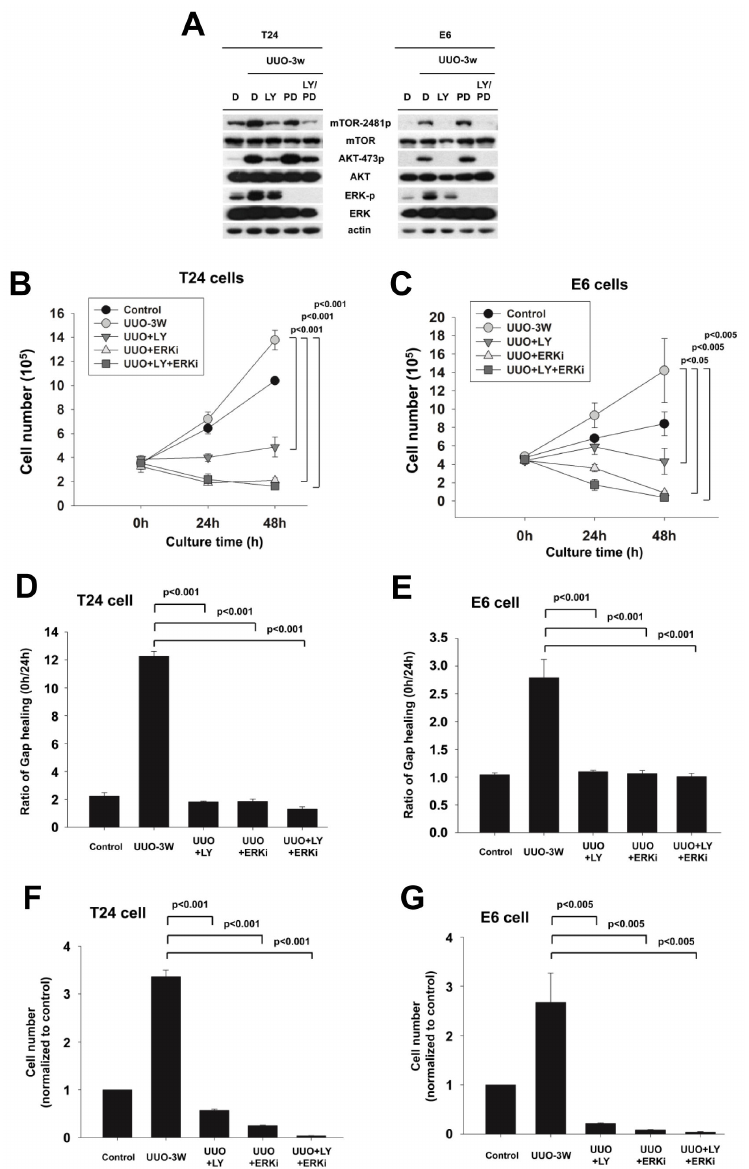
Figure 6. Inhibition of mTORC2-AKT and ERK signaling pathway reduced T24 cells and E6 cells cell viability, migration and invasion in hydronephrotic urine treatment. To confirm the importance of mTORC2-AKT and ERK signaling pathway in T24 and E6 cells after the treatment of hydronephrotic urine, we used LY294002 (PI3K inhibitor) and PD184352 (ERK inhibitor) to analysis the cell function. (A) T24 cells and E6 cells were cultured in serum free medium and treated with LY294002 (20µM) and PD184352 (10µM) for 60 min and stimulated with 20µl/ml hydronephrotic urine from UUO 3 weeks for 30 min. The phosphorylation of mTOR-Ser2481, AKT-Ser473 and ERK were detected by western blotting (D: DMSO, LY: LY294002, PD: PD184352). (B, C) T24 cells and E6 cells were cultured in serum free medium and treated with LY294002 (20µM) and PD184352 (10µM) and stimulated with 20µl/ml hydronephrotic urine from UUO 3 weeks. The cells would be counted the cell number after treatment for 0, 24 and 48 hrs, respectively (Control: without hydronephrotic urine treatment, LY: LY294002, ERKi: PD184352). (D, E) T24 cells and E6 cells were cultured in serum free medium and treated with LY294002 (20µM) and PD184352 (10µM) and stimulated with 20µl/ml hydronephrotic urine from UUO 3 weeks for 24 hrs. The cells would be analyzed the migration capability by wound healing assay (Control: without hydronephrotic urine treatment, LY: LY294002, ERKi: PD184352). (F, G) T24 cells and E6 cells were cultured in serum free medium and treated with LY294002 (20µM) and PD184352 (10µM) and stimulated with 20µl/ml hydronephrotic urine from UUO 3 weeks for 12 hrs. The cells would be analyzed the invasion capability by transwell motility assay (Control: without hydronephrotic urine treatment, LY: LY294002, ERKi: PD184352). doi: 10.1371/journal.pone.0074300.g006 PLOS ONE |